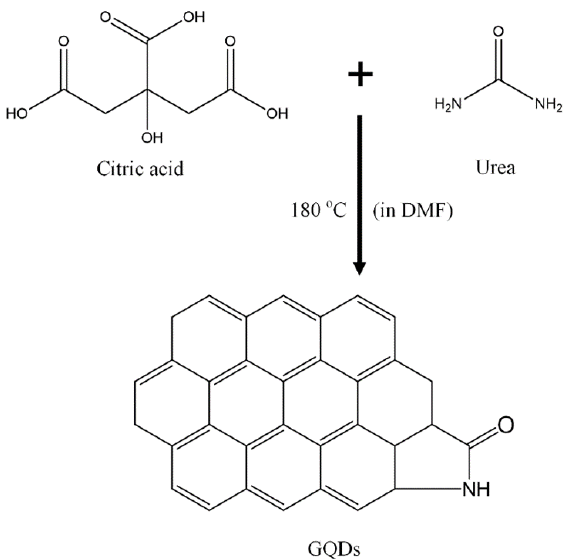
Figure 4: Solvothermal synthesis of pyrrolic nitrogen-doped GQDs (pN-GQDs), starting from citric acid (carbon source) and urea (nitrogen source) (Noor et al .,